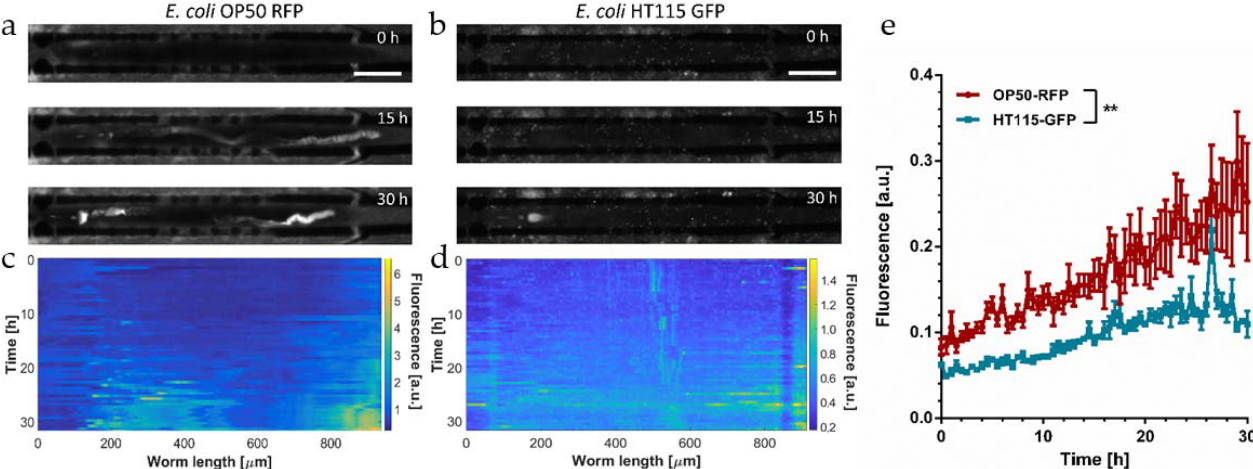
Figure 3. Analysis of the bacterial load in immobilized adult N2 C. elegans worms fed fluorescently marked E. coli bacteria. Fluorophores with different pH sensitivity were used to label the bacterial food. ( a ) Time-lapse sequence of fluorescence images (20 × ) over 30 h of a N2 worm fed E. coli OP50 RFP (pH-insensitive), and ( b ) of a N2 worm fed E. coli HT115 GFP (pH-sensitive). In the aging worms, an increase in fluorescence in distinct sections of the gut is observed, in particular in the pharyngeal region (for OP50 RFP and HT115 GFP), and in the hindgut (only for OP50 RFP). The strong RFP signal in the posterior region of the intestine is due to the presence of a mixture of intact bacteria and disrupted bacteria. Unlike HT115 GFP, both signals persist due to RFP pH insensitivity. ( c , d ) Color-coded maps of the fluorescence intensity measured over the whole worm gut, representing the evolution of the bacterial load over 30 h, for the worms fed OP50 RFP ( c ) and HT115 GFP ( d ), respectively. ( e ) Total fluorescence averaged over the entire worm gut over 30 h for both cases. A general increase over time of the bacterial load is observed, which is particularly evident in worms fed the OP50 RFP strain. In HT115 GFP-fed worms, the overall intensity of fluorescence is lower due to the acidic environment of the hindgut. Values have been normalized with respect to the maximum fluorescence in the pharynx occurring for an event of maximum bacterial intake. (** p ≤ 0.1, n = 10 for each condition). Error bars correspond to mean ± SD. Scale bars = 100 µ